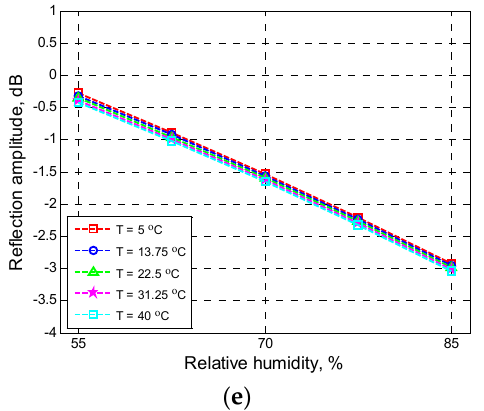
Figure 6. Effect of temperature ( a , b ) and relative humidity ( c – e ). By the same token, the influence of changing chloride contamination level parameters (i.e., CL) and varying rebar corrosion status variables (i.e., CS) coupled with changing other input parameters to the output is presented in Figure 7. While Figure 7a–c represents the changing chloride contamination level, Figure 7d–f presents the effects of variation of rebar corrosion status on the amplitude of GPR signals from rebar.